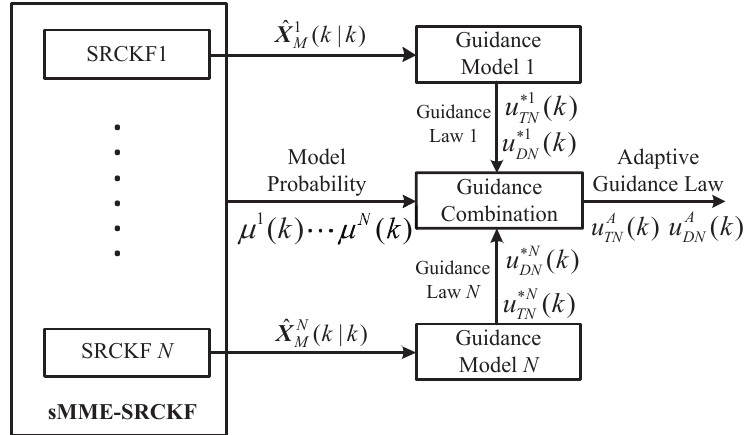
Figure 3. The structure of adaptive cooperative guidance